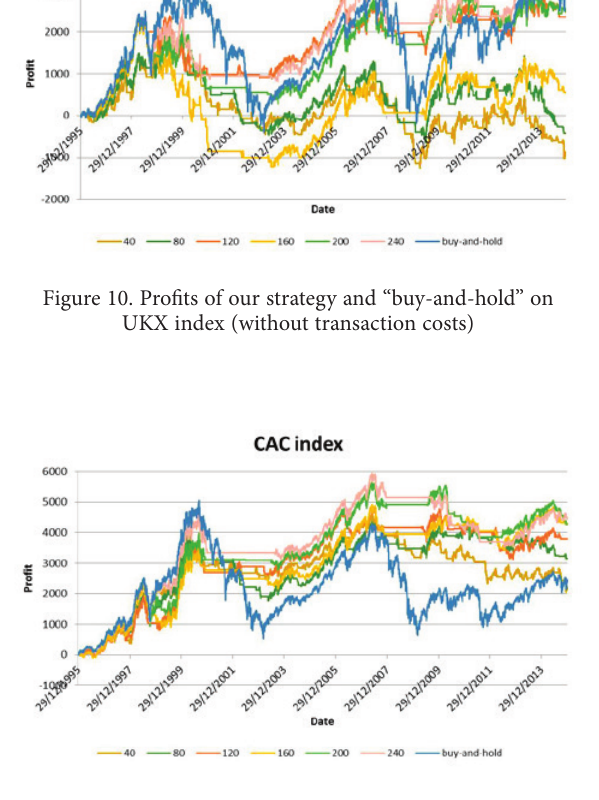
Figure 11. Profits of our strategy and “buy-and-hold” on CAC index (without transaction costs)